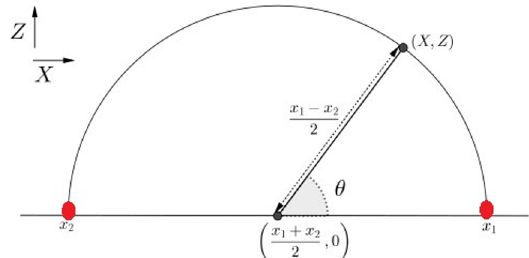
) and ( x 2 , p + ) correspond 1 2